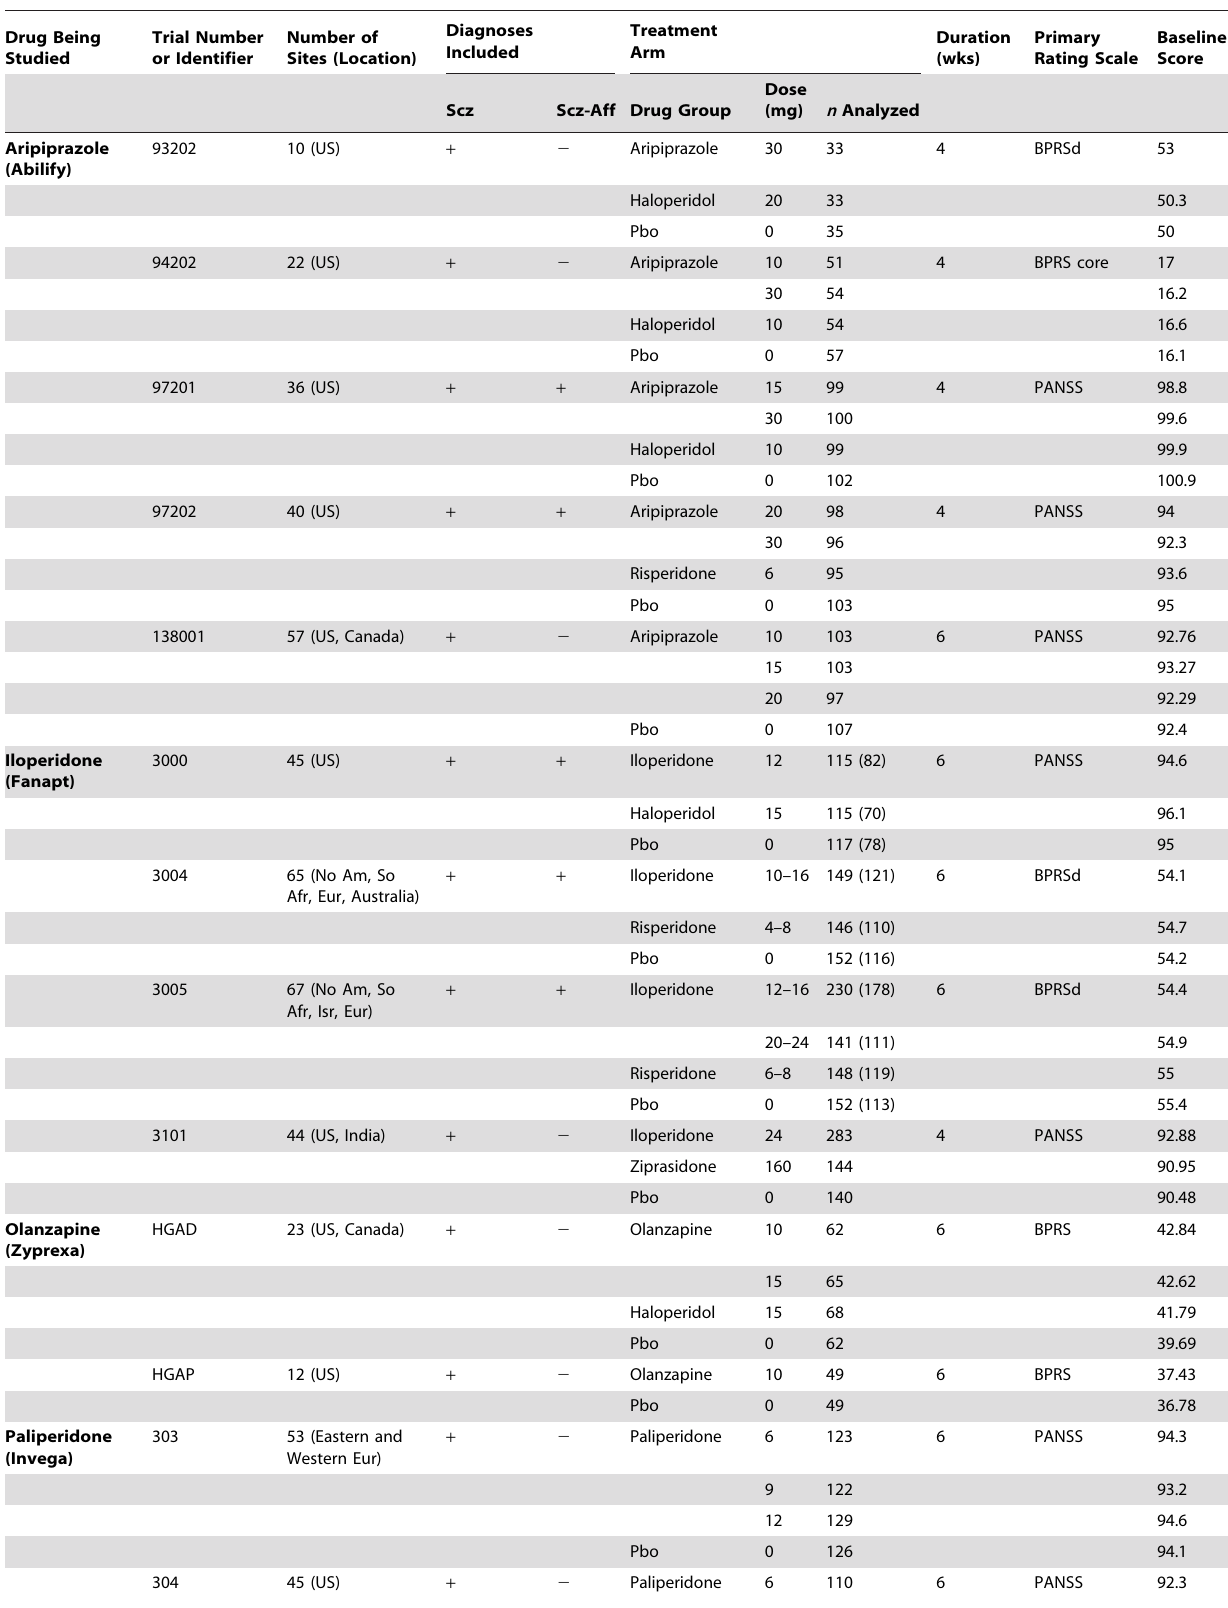
Table 1. Characteristics of premarketing trials of antipsychotics according to FDA.